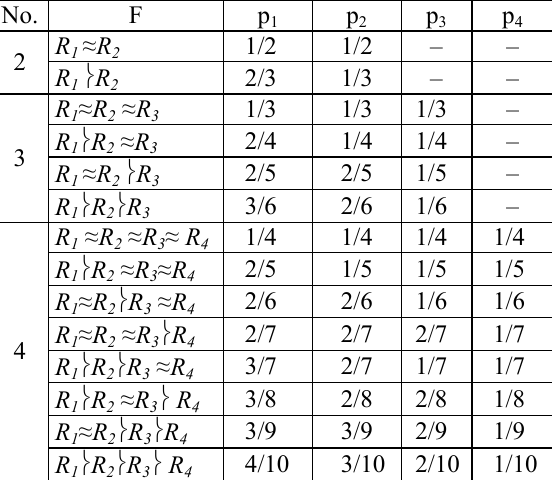
Table 1. Fishburn's weight coefficient system